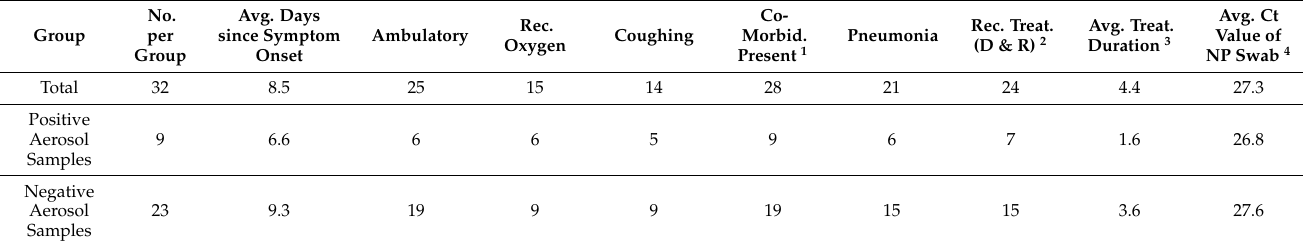
Table 1. Summary of participant characteristics at the time of sampling.